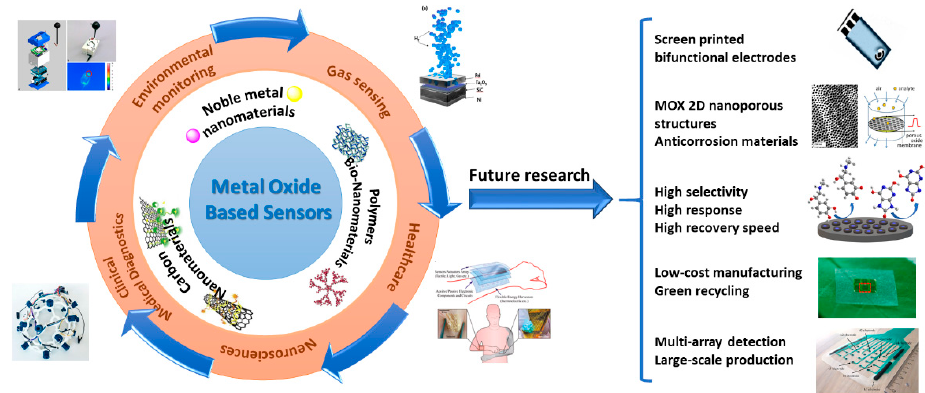
Figure 17. Illustration about the main recent applications and future research directions of sensors. Figures are reused under the terms of CC-BY license from Refs. [161–167].